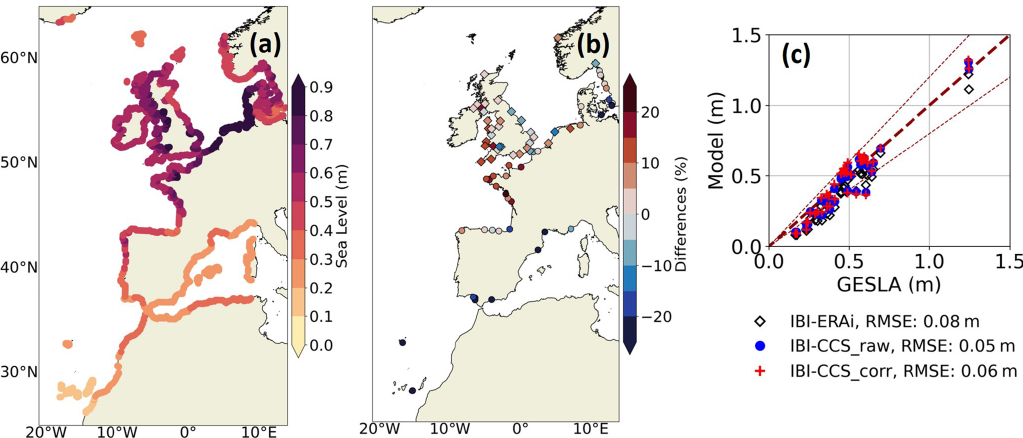
Figure 8. (a) Non-tidal residuals 99th percentile values over the 1993–2014 period in IBI-CCS_corr. (b) Relative error of the non-tidal residuals 99th percentile of IBI-CCS_corr compared to GESLA TG data over the 1993–2014 period. Circles represent TG data at 1h frequency and the diamonds indicate TG data at higher frequency. (c) Scatter plot of simulated vs. observed 99th percentile at TG stations in IBI-ERAi (white diamonds), IBI-CCS_raw (blue circles) and IBI-CCS_corr (red cross). The thin dashed dark red lines indicate the 20% error